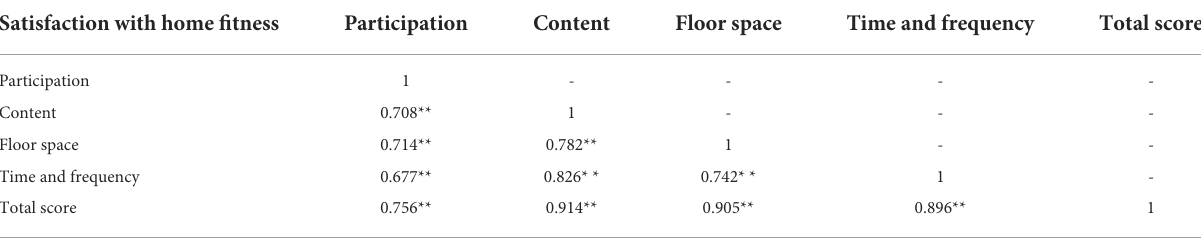
TABLE 3 Correlation coefficients of factors in the questionnaire of satisfaction with home fitness and between factors and the total score. Satisfaction with home fitness